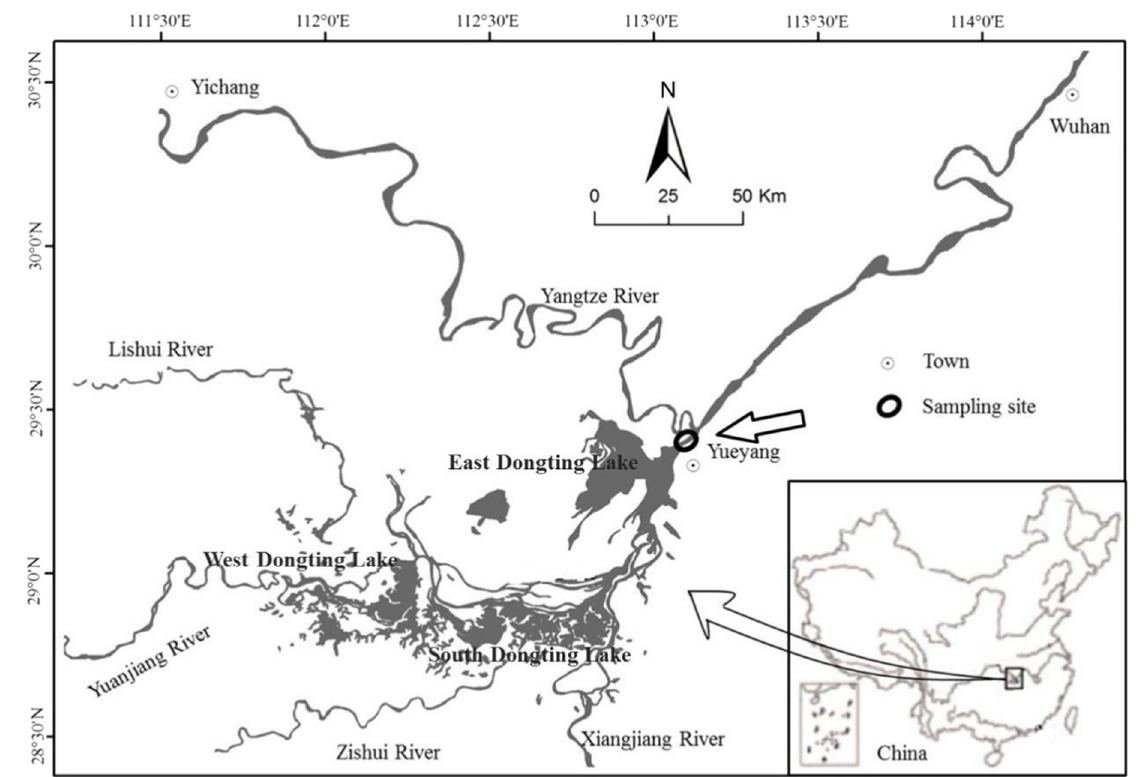
Fig. 1. A map of Dongting Lake and the sampling site in the channel connecting Dongting Lake and the Yangtze